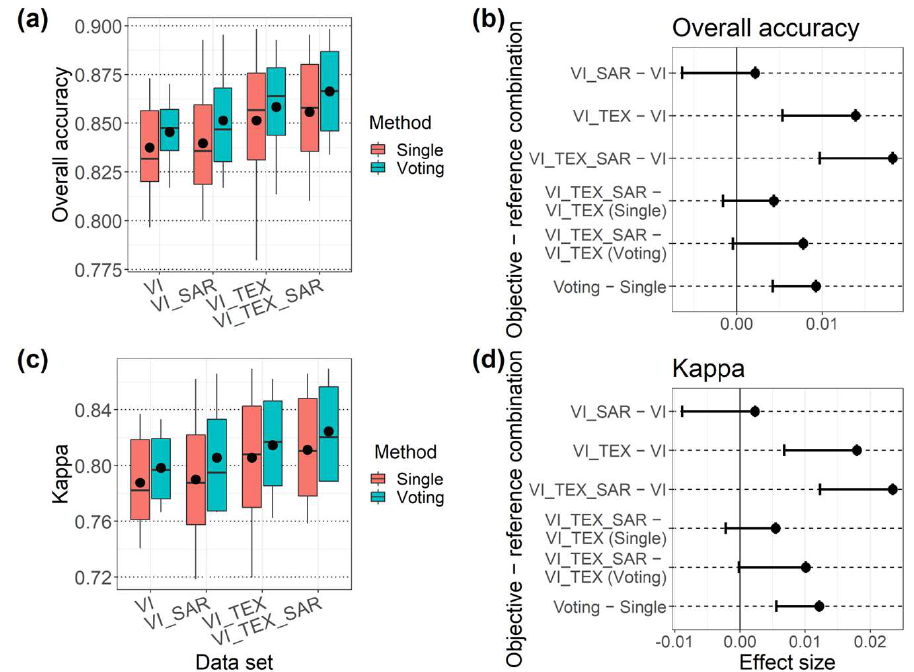
Figure 3. Comparison of the overall model classification performance according to the different data set and learning method combinations. Data sets are indicated with code names explained in Table 2. The box plots represent the distribution of the ( a ) overall accuracy and ( c ) Kappa coefficient for each model and learning method. Blue and red represent the results of the single and voted models, respectively, and dots represent the mean value of each metric for each data set. The interval plots represent the results of multiple comparisons (Dunnett’s test) with the linear mixed model for ( b ) overall accuracy and ( d ) Kappa coefficient. The y-axis of the interval plot represents the combination of the objective and reference data set/method; the former is the objective and the latter is the refer- ence. Dots represent the effect size of each data set/method for the objective data set/method, com- pared to the reference data set/method. The error bar represents the lower limit of the 95% confi- dence interval in the one-tailed test. The result for the single model is a summary of the sixteen single models, and that for the voted model is a summary of the four voted models. The simple ensemble learning (i.e., voting) enhanced the mean overall classification accuracy when compared to the single models; this trend was consistent for every data set (Figure 3a). The highest average overall classification accuracy for both single and voted models was achieved when we used the VI_TEX_SAR data set with the voting method (OA, 0.866; SD, 0.030), but there was little difference (mean, 0.008; 95% CI, −0.0004–) from the voted model with VI_TEX data set (OA, 0.858; SD, 0.034). 3.2. The Classification Performance for Each Vegetation Type The results related to the user’s accuracy are shown in Figure 4a,b. The user’s accu- racy for the forest class was significantly improved when adding GLCM texture or both SAR bands and texture to the base VI data set (mean, 0.043; 95% CI, 0.028–; and mean, 0.049; 95% CI, 0.034–, respectively), but adding only SAR bands showed a limited effect (mean, 0.015; 95% CI, −0.0007–). Adding both SAR bands and GLCM texture to the base data set significantly improved the user’s accuracy for the vine class (mean, 0.026; 95% CI, 0.005–), while adding only the GLCM texture showed a smaller effect (mean, 0.018; 95% CI, −0.0025–) and SAR bands showed little effect (mean, 0.0029; 95% CI, −0.015–). The trend for the fern class was different from that of the forest or vine classes; the accuracy was highest in the base data set and adding GLCM textures, SAR bands, or both of them showed a negative effect (mean, −0.021; 95% CI, −0.041–; mean, −0.029; 95% CI, −0.050–;